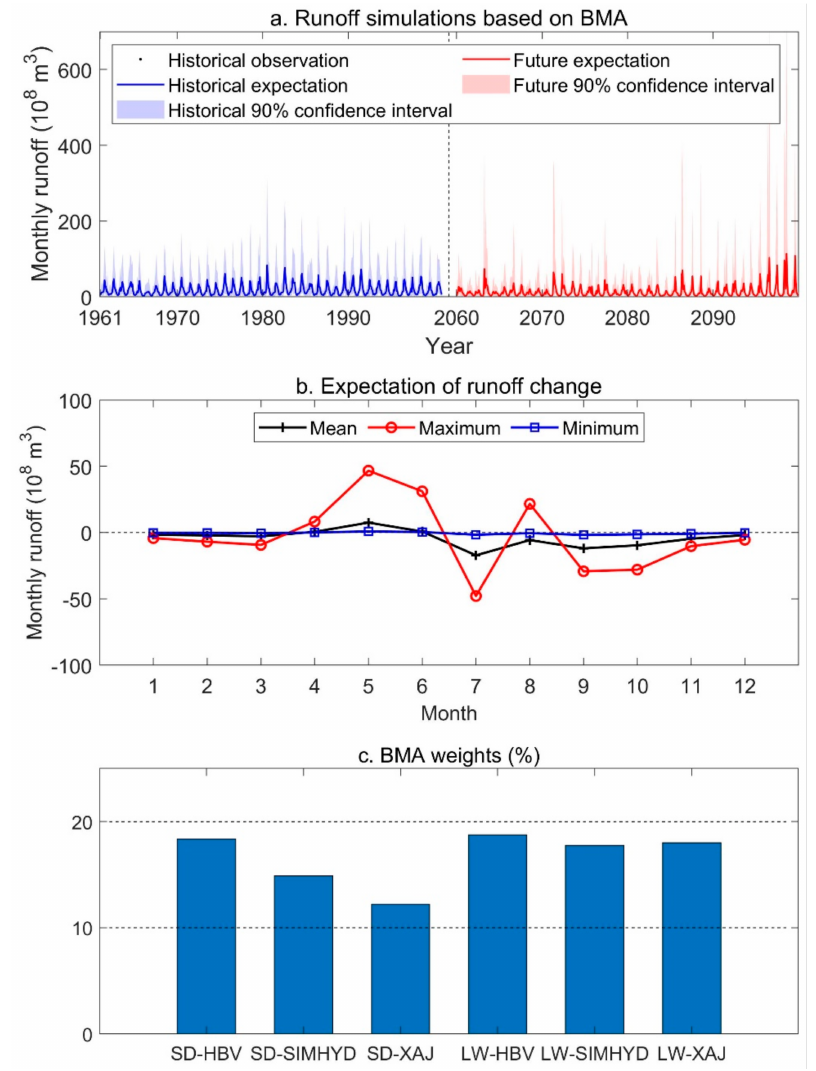
Figure 6. Runoff simulations and BMA weights computed over the entire baseline period. ( a ), Expec- tation and ensemble spread within the 90% confidence interval in the baseline and future periods; ( b ), Projected changes in mean, maximum, and minimum monthly runoff from the baseline to the future; ( c ), BMA weights of the six ensemble